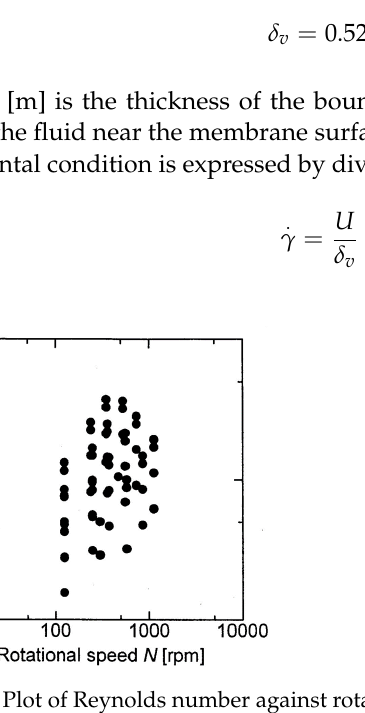
Figure 14. Plot of Reynolds number against rotational speed.